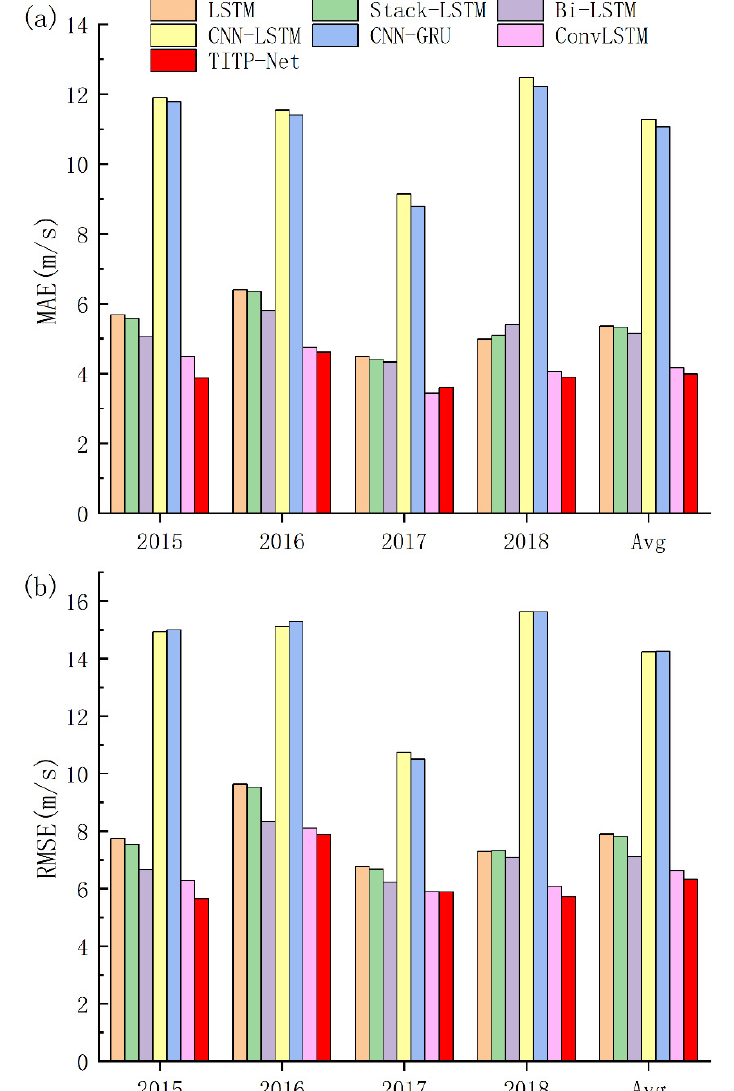
Figure 9. The results of typhoon intensity prediction at a lead time of 24 h based on different models. ( a ) Evaluation of the MAE metric in different years and the four-year average error. Different colored histograms represent different models, including LSTM, Stack-LSTM, Bi-LSTM, CNN-LSTM, CNN-GRU, ConvLSTM and TITP-Net. Each histograms shows the performance of typhoon intensity in 24 h prediction in different years. The red histograms show the prediction error in 24 h of the best-performance model. ( b ) Evaluation of the RMSE metric in different years and the four-year average error.